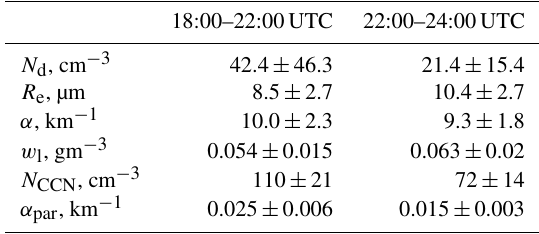
Table 2. Mean values and standard deviations of cloud properties observed in the liquid-water cloud layer at 3km height on 23 Febru- ary 2019. The aerosol properties for the height range from 375– 600m below the cloud base are given in addition. During the se- lected averaging periods (before and after 22:00UTC), very differ- ent cloud and aerosol properties were